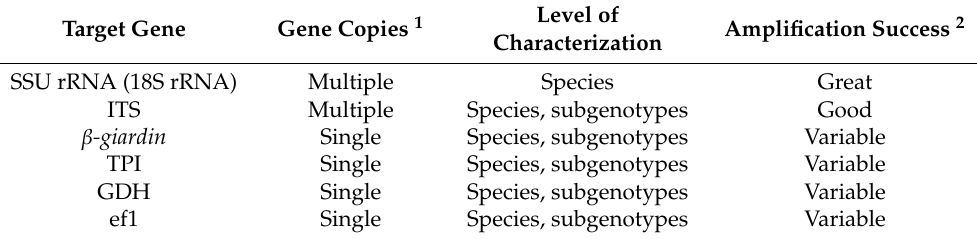
Table 6. Target genes used in Giardia spp. characterization. Adapted from